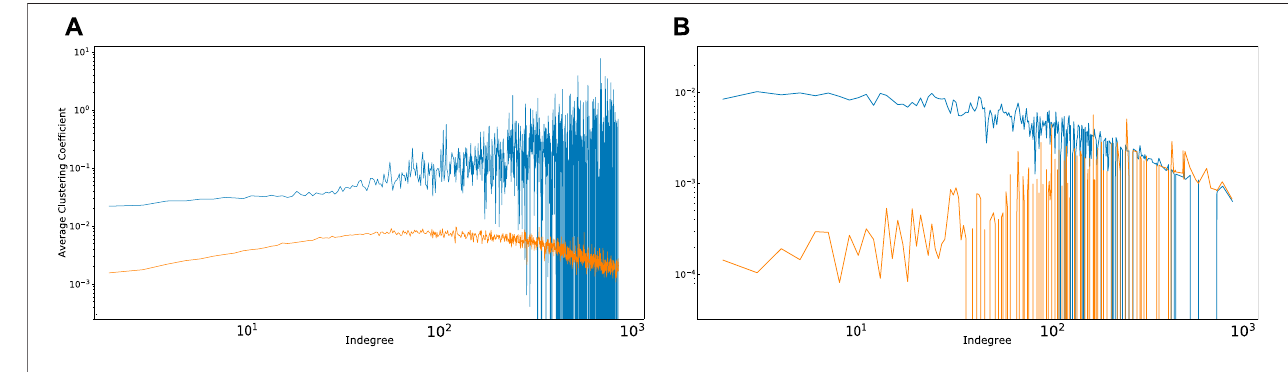
FIGURE 3 | Local average clustering coef fi cient of cases as a function of indegree. (A) The complete network (B) The cross-jurisdiction network. Cases with high degrees present lower clustering coef fi cients. The complete and cross-jurisdictional networks are shown in blue, their randomized counterparts are shown in orange.